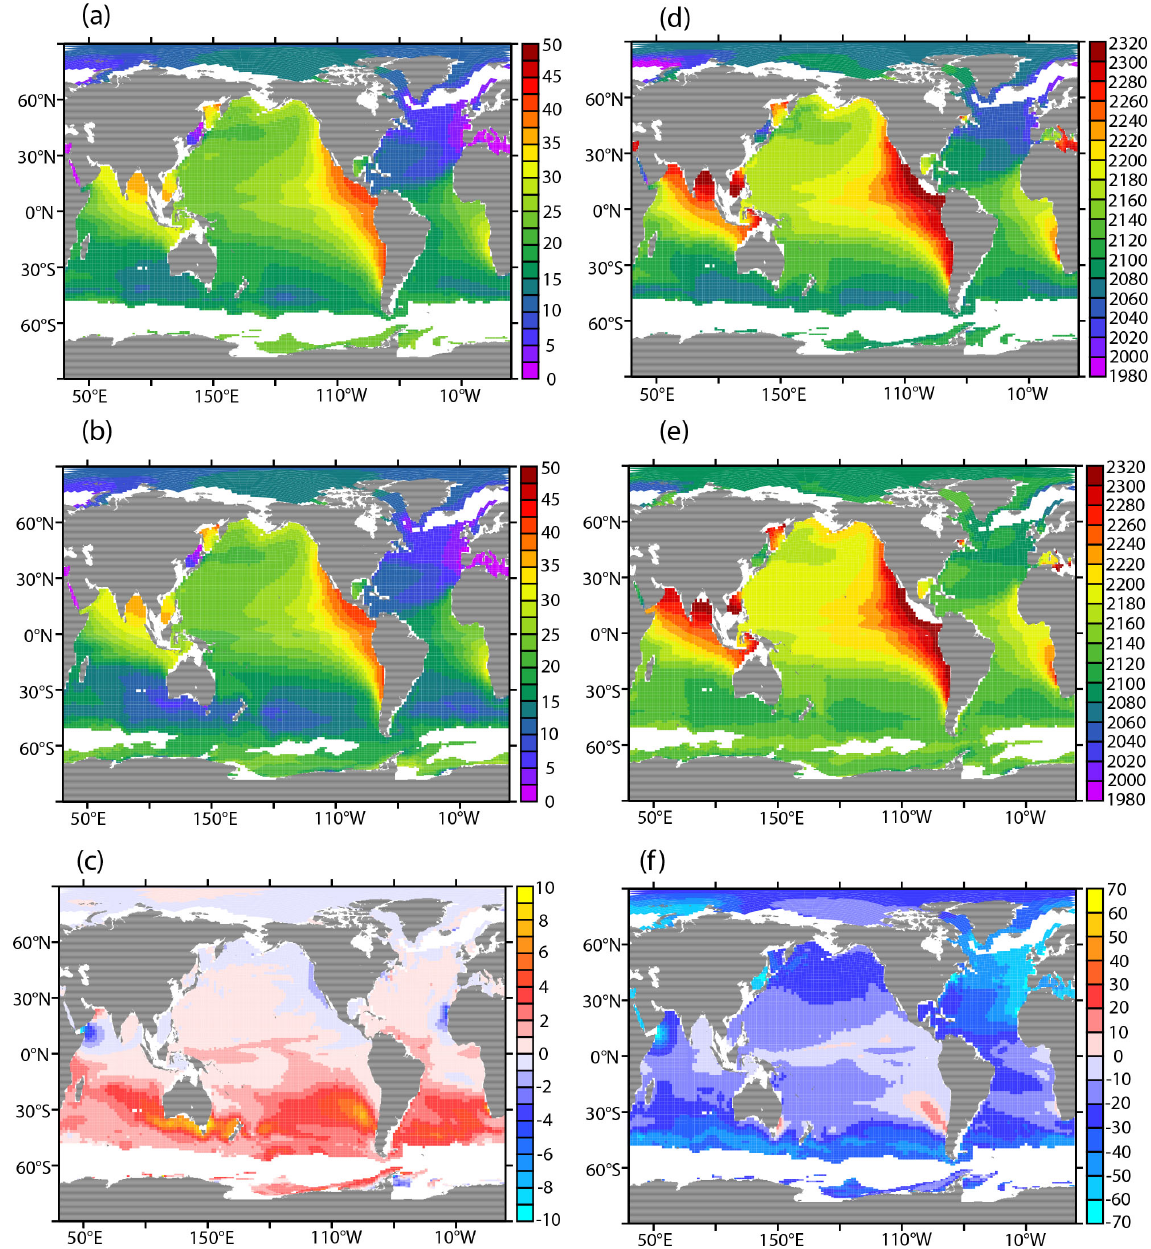
Figure 12. Ocean interior concentrations ( σ 0 = 26 . 8) are shown averaged over years 2000–2006 for (a) NO 3 in WSTIR, (b) NO 3 in CNTRL, and (c) the difference in NO 3 between WSTIR and CNTRL (units of µM). Ocean interior concentrations ( σ 0 = 26 . 8) are shown averaged over years 2000–2006 for (d) DIC in WSTIR, (e) DIC in CNTRL, and (f) the difference in DIC between WSTIR and CNTRL (units of